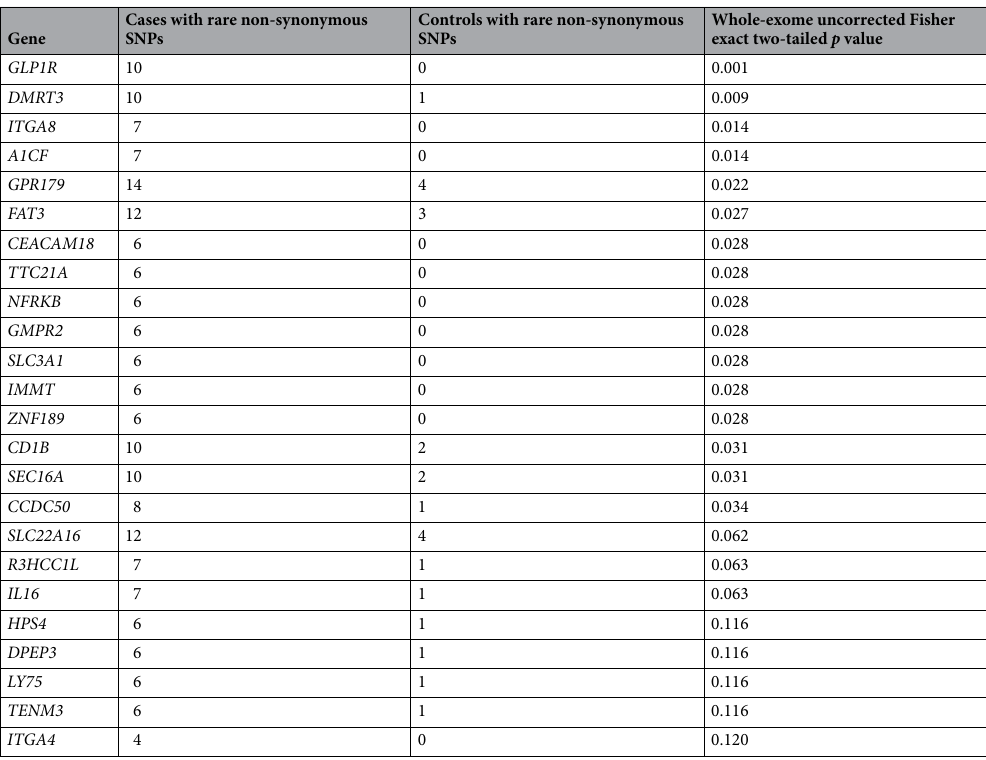
Table 4. Genes selected from the discovery cohort with SNPs of MAF <